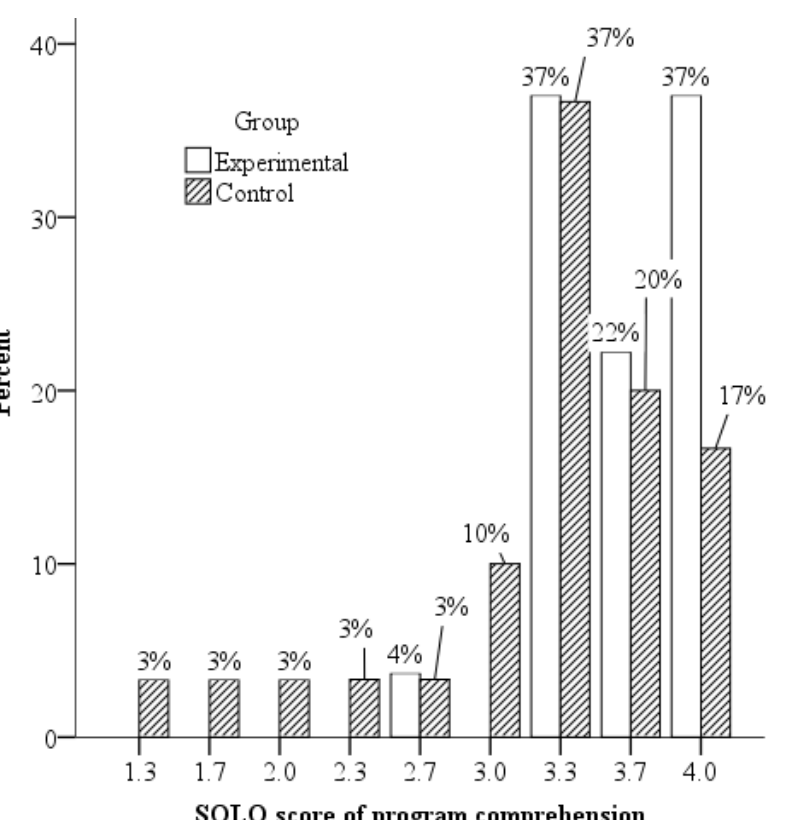
Figure 3. Distribution of the SOLO scores of program comprehension.